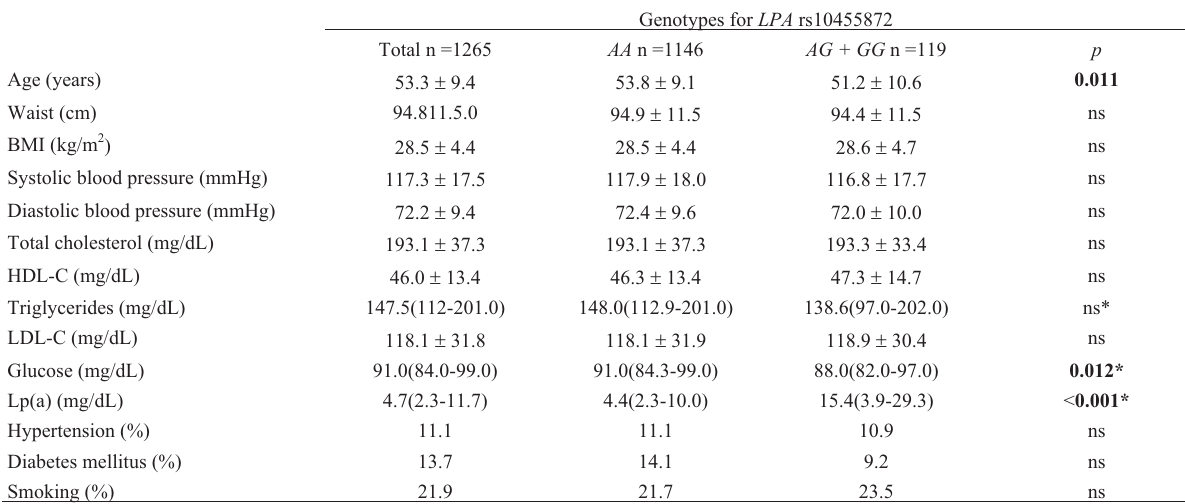
Table 1 - Characteristics of the Mexican-Mestizo population according to LPA rs10455872 genotype.